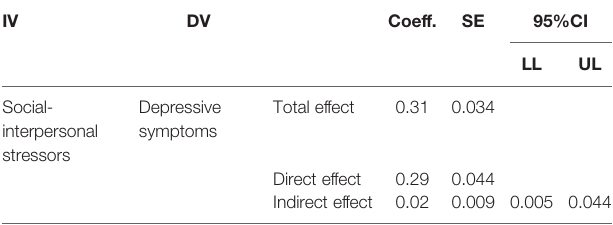
TABLE 3 | Test of the mediation